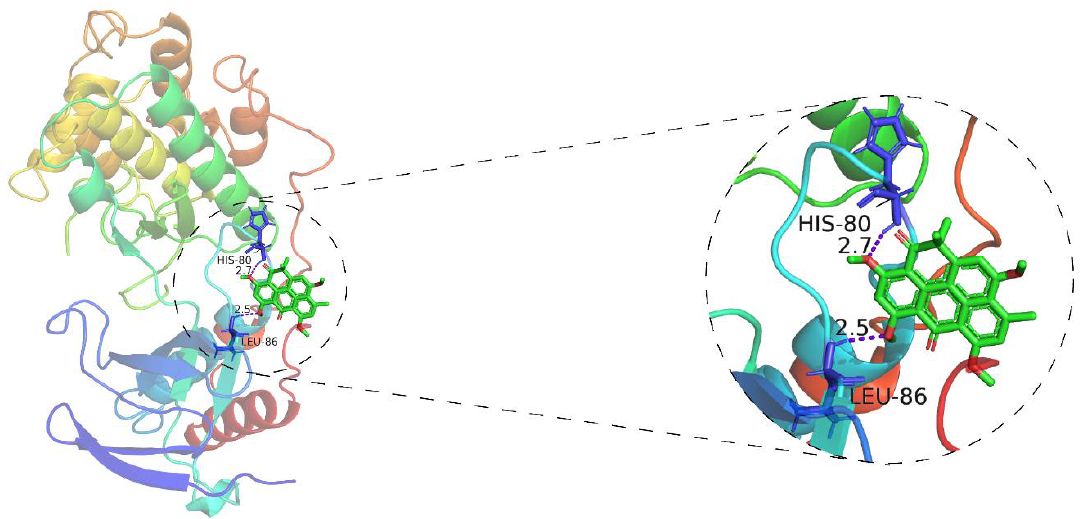
Figure 7. AutoDockTools software was employed to obtain the optimal docking model of resistomycin to the p38, and the resulting image is a panoramic view of the optimal binding method (Purple dotted line: hydrogen-bond). The lowest binding energy configuration is −6.92 kcal/mol.